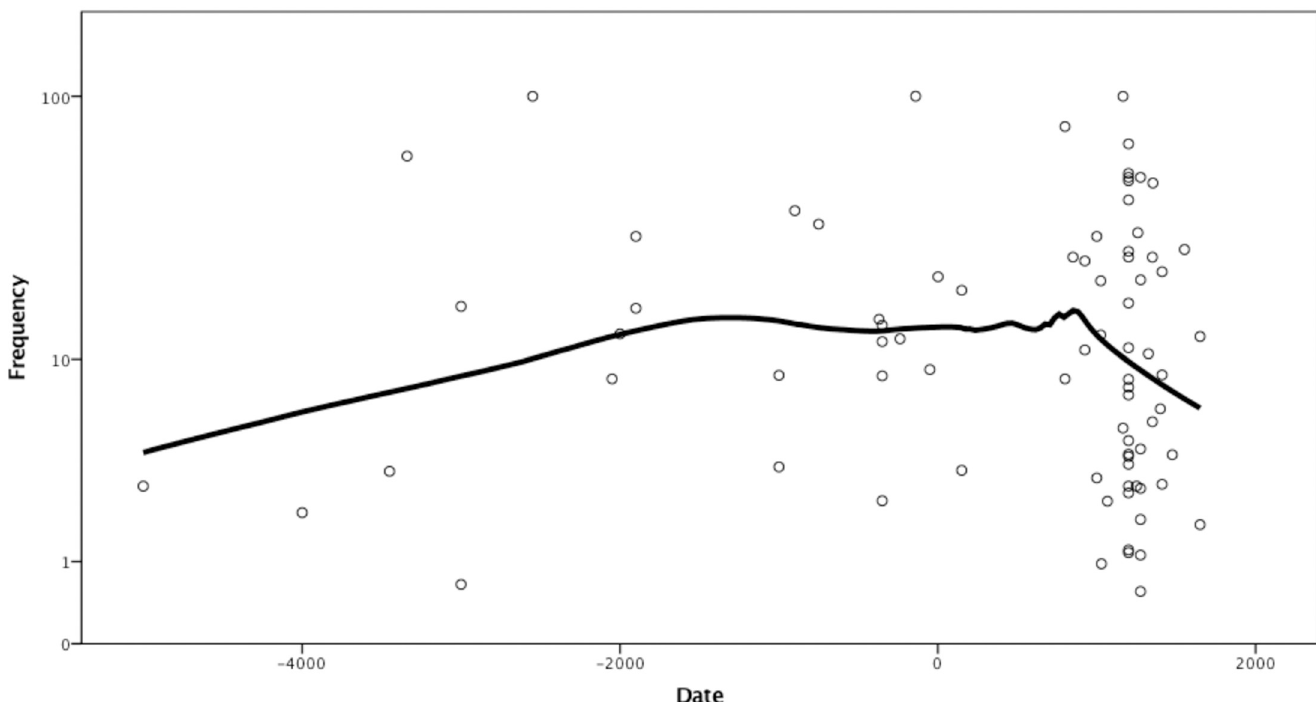
Fig 2. Logarithmed frequency of skeletal signs of treponematoses by date. LOESS curve fitted with 70% of points included and tricube kernel. Frequency scale logarithmic.